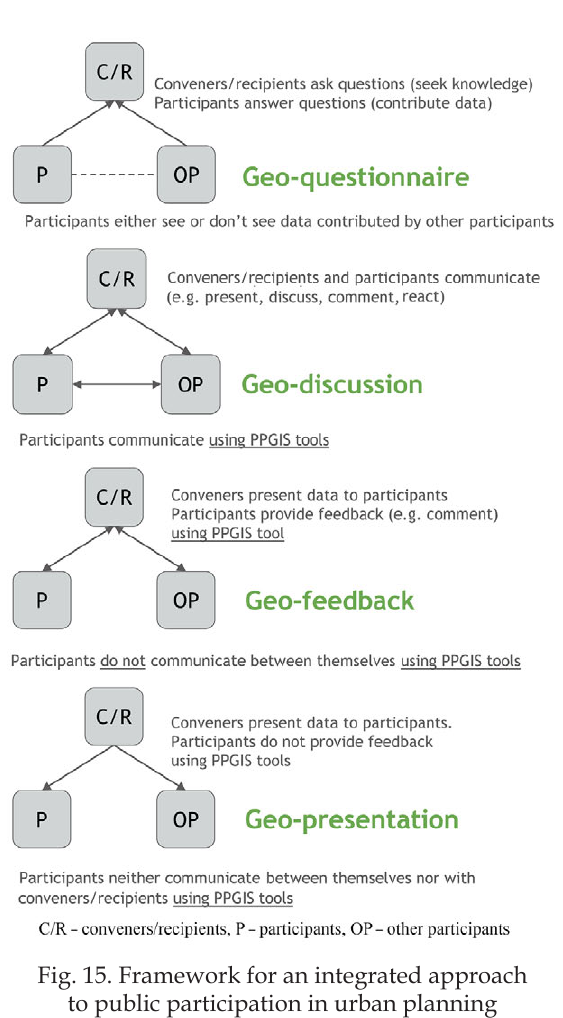
Fig. 15. Framework for an integrated approach to public participation in urban planning (by M. Czepkiewicz et